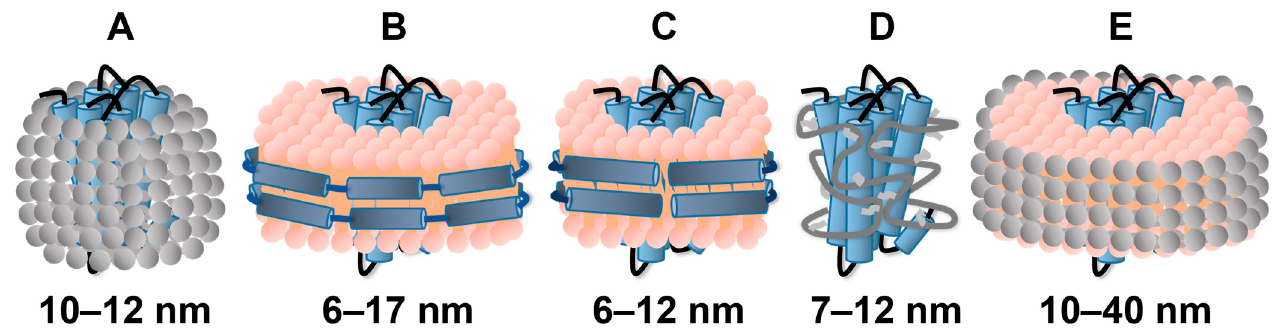
Figure 2. Cartoon representation of GPCRs embedded in five different membrane mimics in use for reconstitution and solubilization for NMR experiments in solution. ( A ) GPCR (blue) stabilized in detergent micelles (gray). ( B ) GPCR (blue) embedded in a nanodisc composed of a lipid bilayer (pink) and membrane scaffold proteins (dark blue). ( C ) GPCR (blue) embedded in a saposin A nanoparticle composed of a lipid bilayer (pink) and saposin A molecules (dark blue). ( D ) GPCR (blue) embedded in amphipathic polymers or amphipols (gray). ( E ) GPCR (blue) embedded in bicelles composed of long-chain lipids (pink) and short-chain lipids or detergent molecules (gray). (Adapted from Figures 2, 4 and 5 of reference [21]; the size ranges indicated below the individual cartoons are taken from reference [23]).